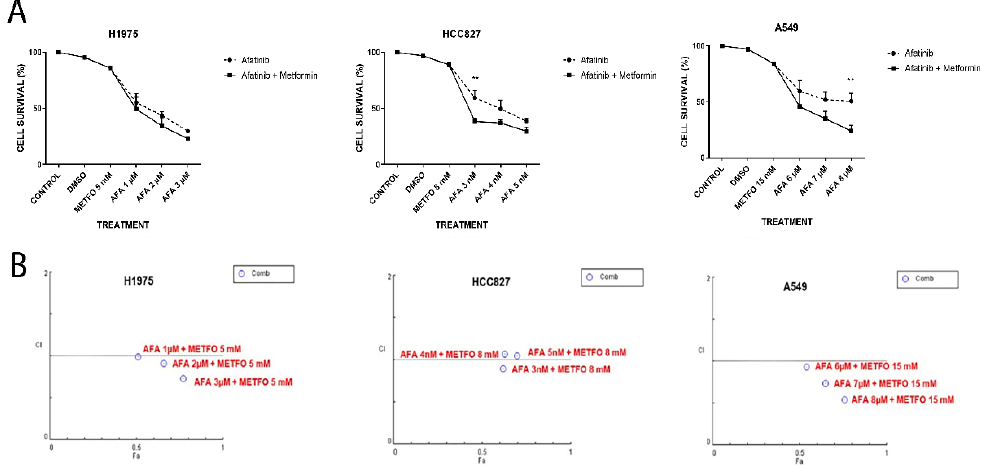
Figure 1. ( A ) Cytotoxic effect of afatinib alone or in combination with metformin in H1975, HCC827, and A549 NSCLC cell lines. Cells were seeded and treated with the previously described schemes for 72 h and MTT assays were performed. Points represent the mean of 3 independent experiments by triplicate. Statistical analysis was performed through two-way ANOVA. ** p ≤ 0.01. ( B ) Combination index plots from NSCLC cell lines. Plots show the different afatinib concentrations for each cell line, in combination with metformin. We observed that the H1975 cell line had synergism with the two highest concentrations of afatinib (2 and 3 µM), the HCC827 cell line had a degree of synergy with the lowest afatinib concentration (3 nM), while a synergic effect in the three combined treatments of the A549 cell line was observed.